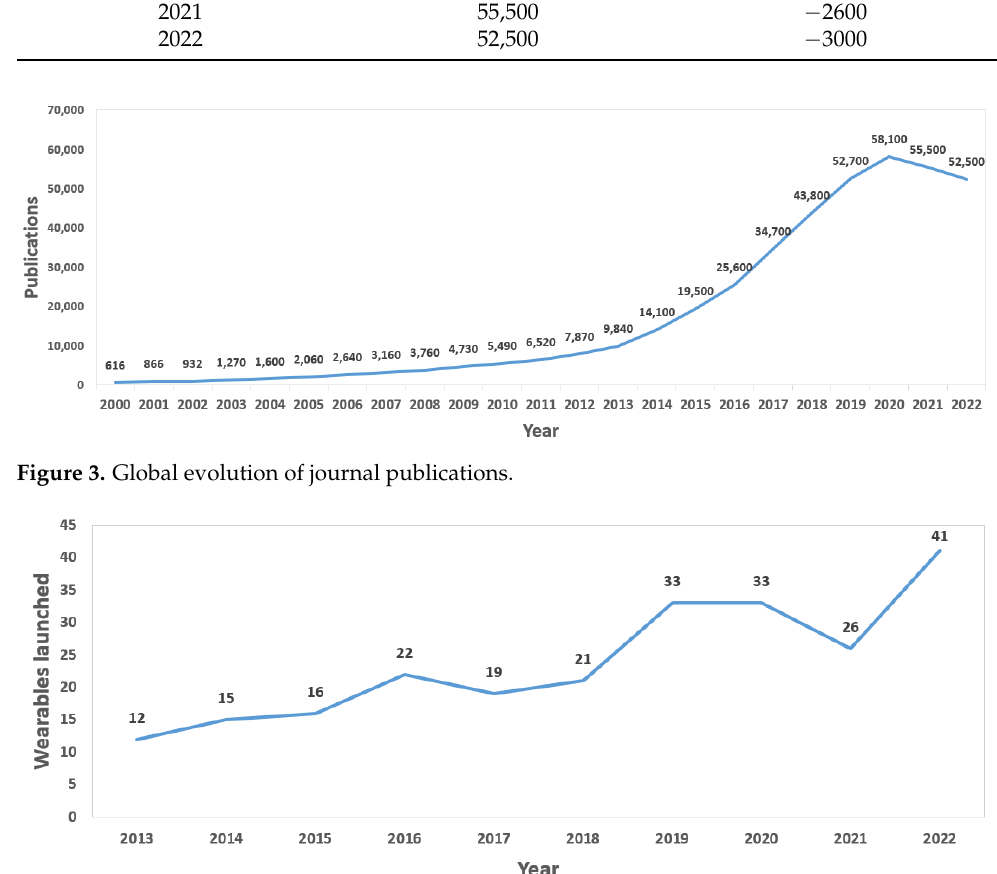
Figure 4. Evolution of commercial wearables launched in the